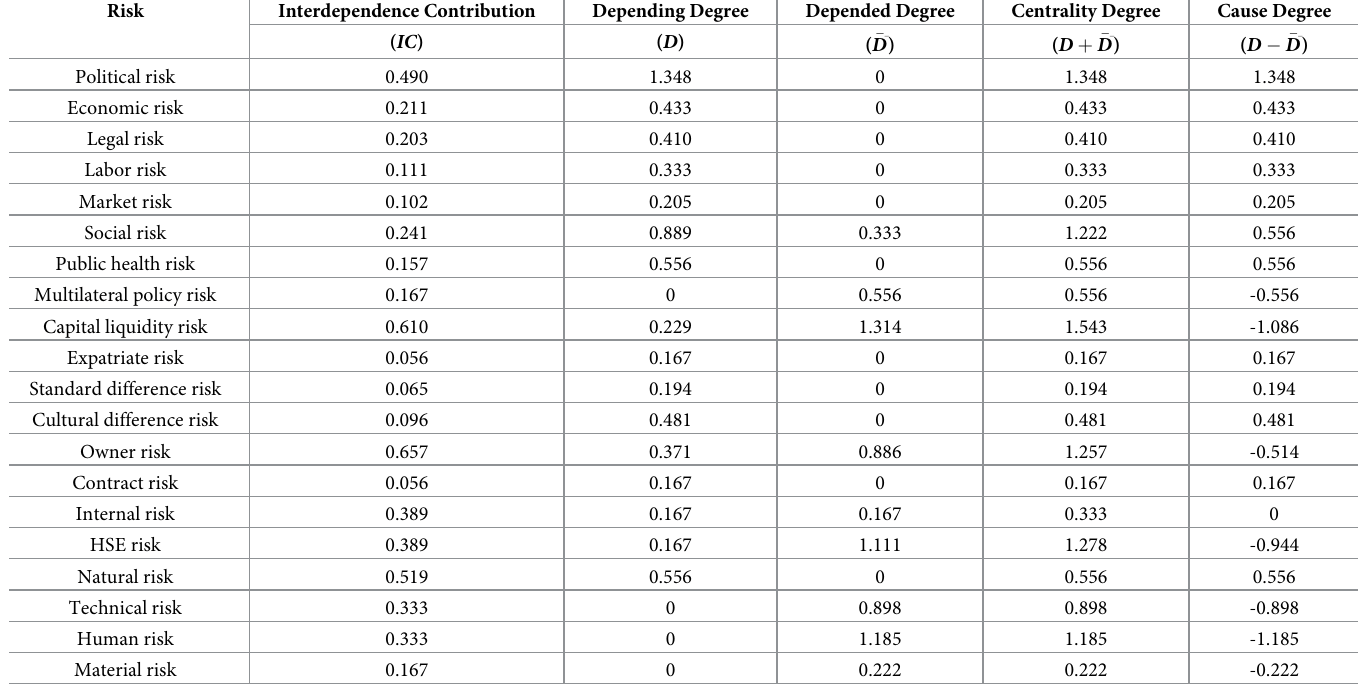
Table 6. Result of the risk interdependence